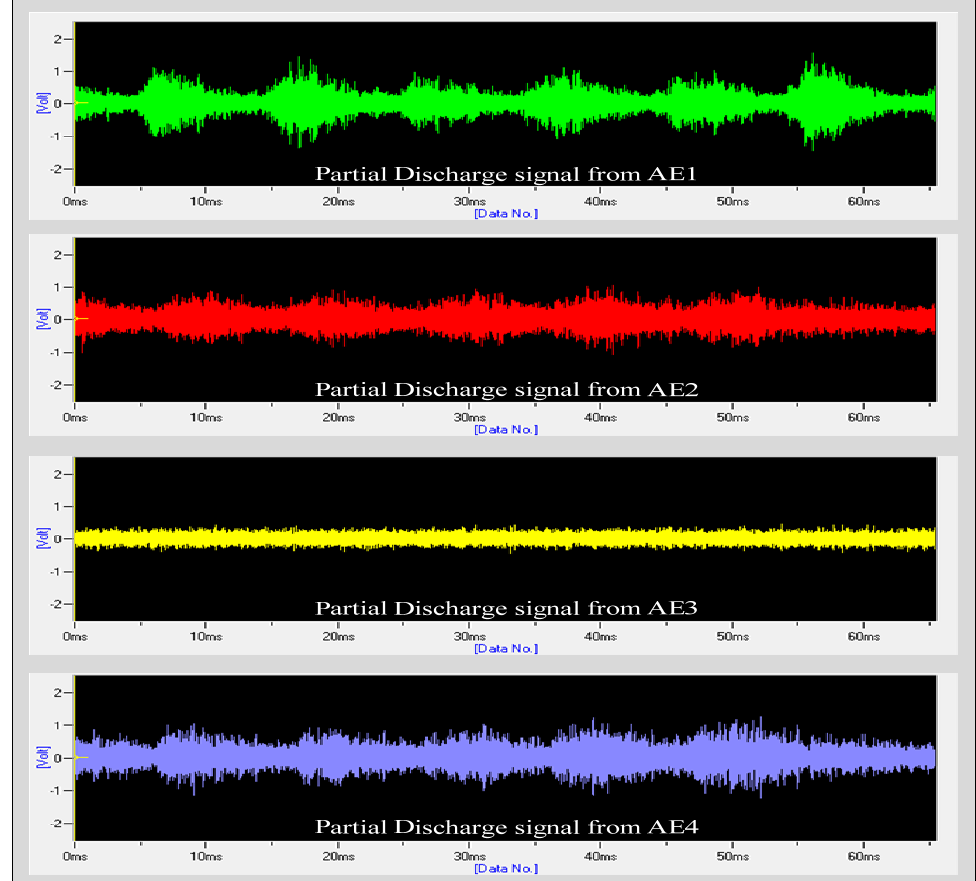
Figure 5. The PD signal waveform obtained from each sensor by four directions installation.